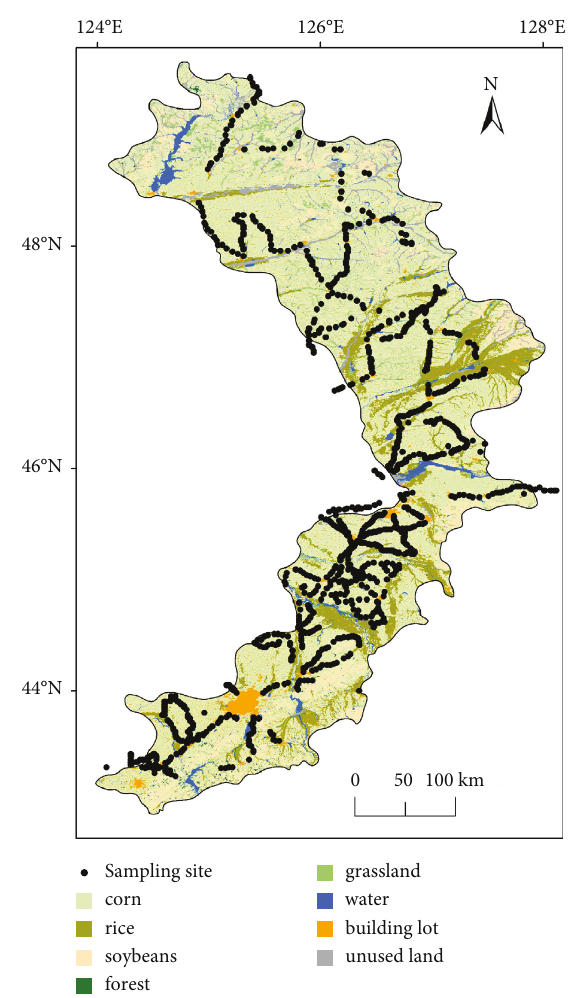
Figure 1: Distribution of sampling points in the study